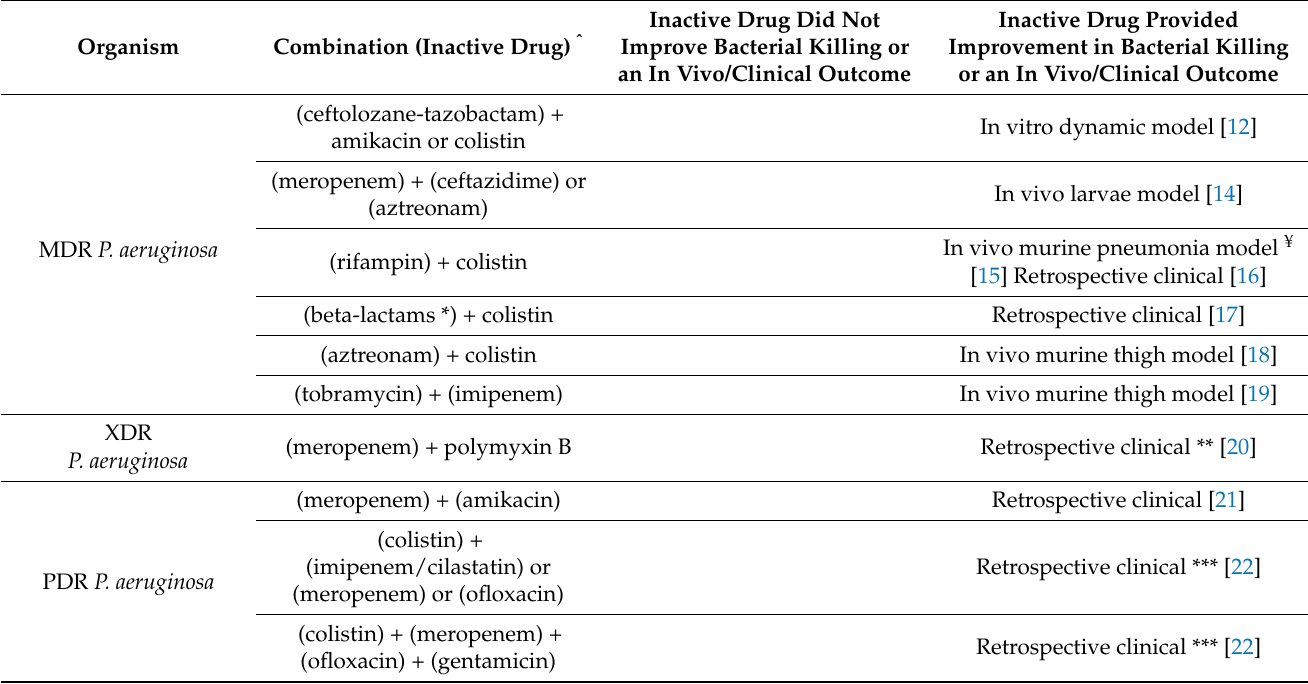
Table 1. Summary of studies that investigated antibacterial combinations against P. aeruginosa that included at least one drug that was inactive individually. Studies are reported in the table if the combination was investigated using a dynamic in vitro model, an in vivo model, or the investigation was completed in the clinic. Susceptibility studies, checkerboard analyses, and static time-killing experiments are not reported in the table due to the preliminary nature of the experiments and the extensive combinatorial permutations that are difficult to summarize